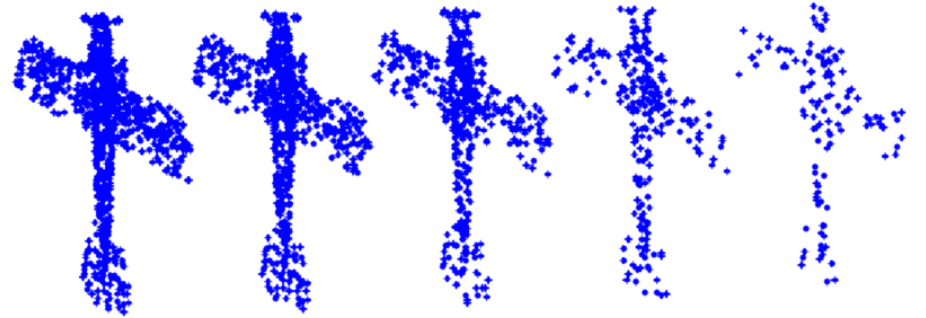
Figure 5. Semantic segmentation results of some scenes in the ScanNet dataset. From left to right, the number of samples of the point clouds is 1024, 768, 512, 256, 128.